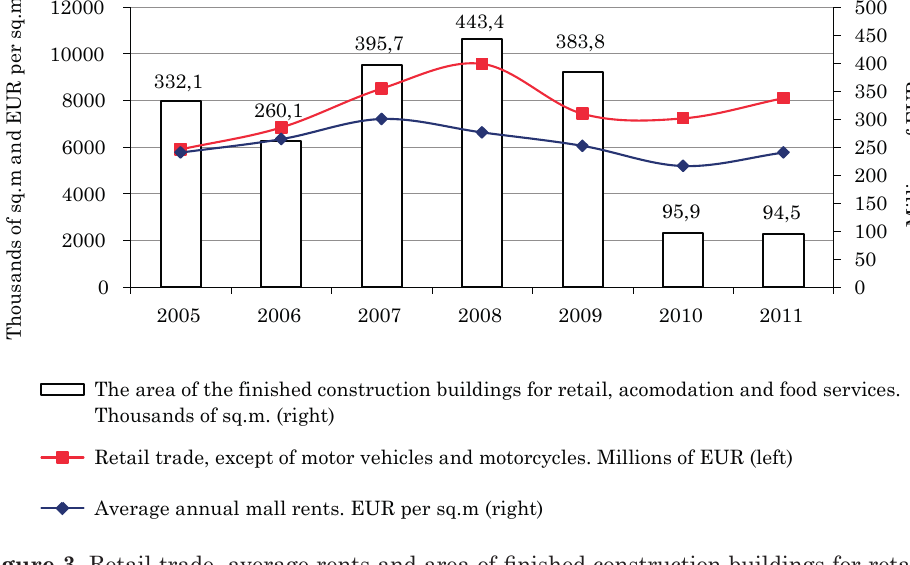
Figure 3. Retail trade, average rents and area of finished construction buildings for retail